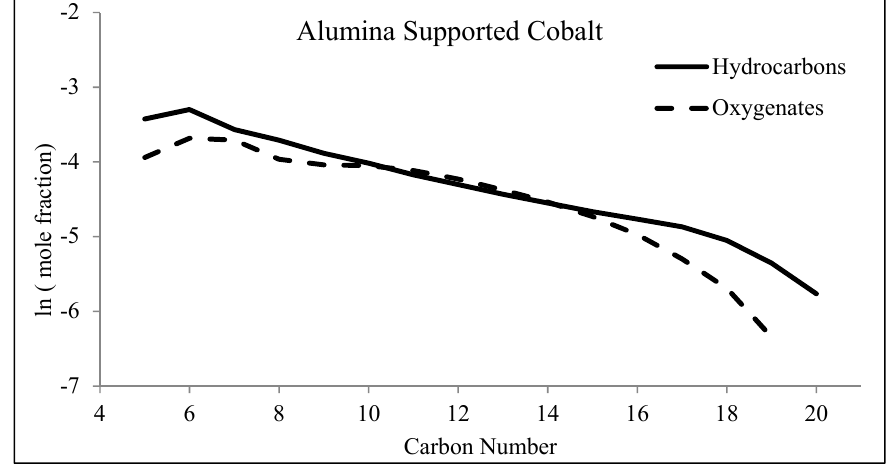
Figure 25. A carbon distribution of the cobalt alumina supported catalyst. Reaction Conditions: 220 °C, 27.6 bar, WHSV = 5, and H 2 /CO = 2.